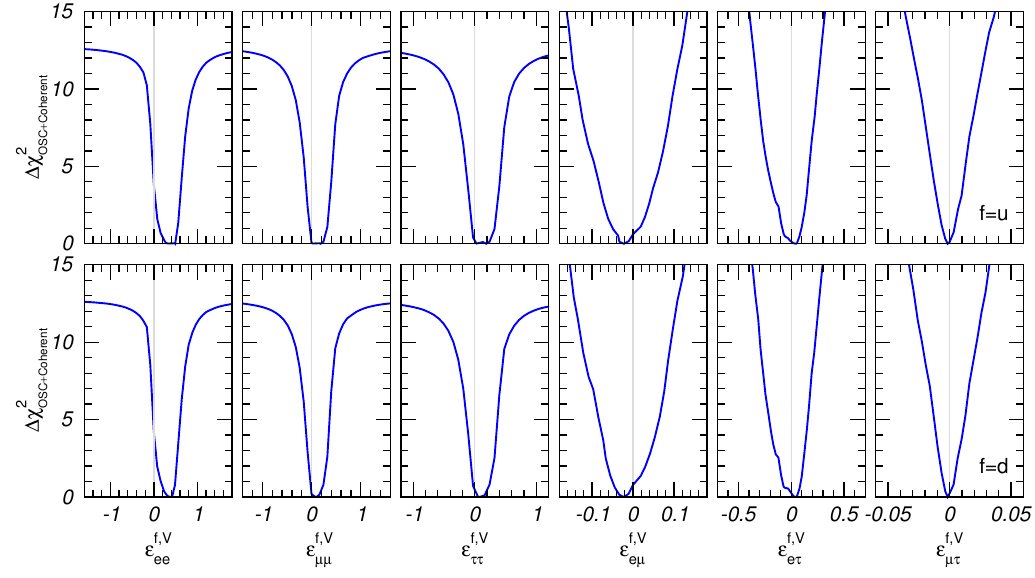
, for a global (cid:12)t to oscillation experi- (cid:11)(cid:12)